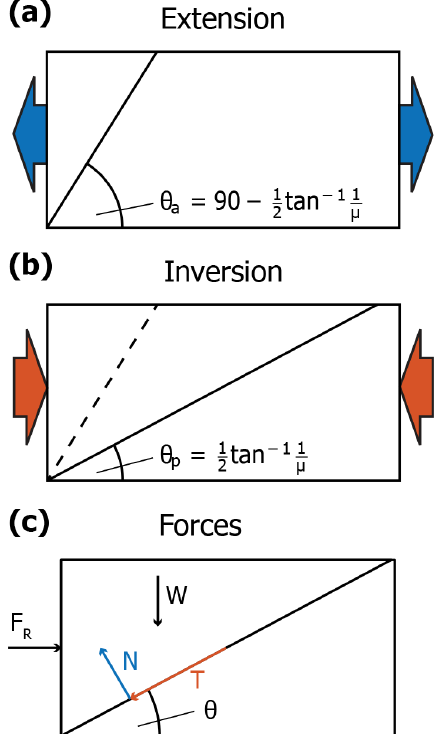
Figure 2. Definition of fault angles during (a) extension and (b) compression. In (b) the pre-existing fault is shown as a dashed line, showing the difference in orientation. (c) Force balance and defini- tion of the force F R required to move a block of weight W along a fault with an angle of θ (modified after Mulugeta and Sokoutis,